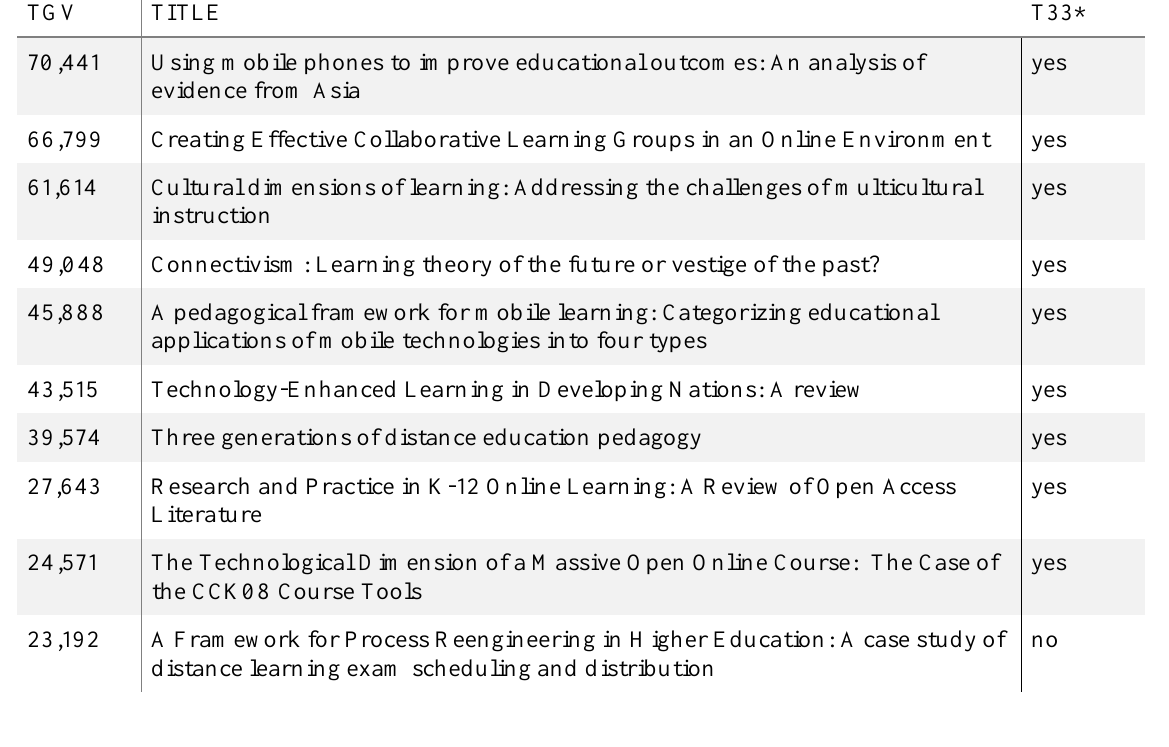
Ten Articles with Most Views (2008-2013)